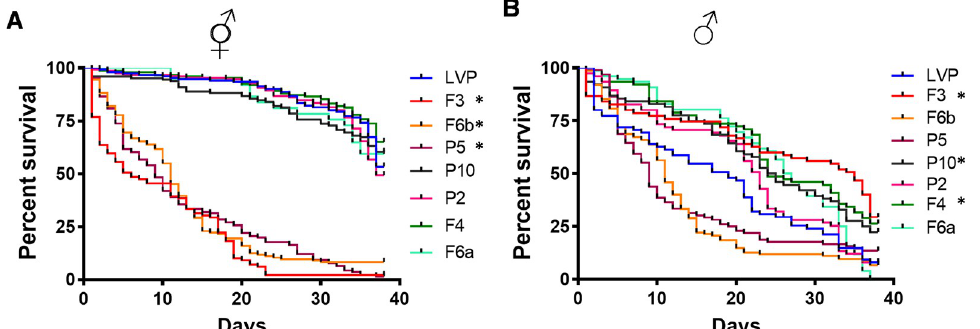
Fig 5. Transgenic females displaying higher masculinization have higher mortality. Survival curves of transgenic ( A ) transgenic females (at least 100 individuals per transgenic line) and ( B ) males (at least 75 individuals per transgenic line) and Liverpool strain (150 females and 75 males) in a total of 38 days of observation. Log-rank test was used to determine P values and statistical significance was determined after the Bonferroni method to correct for multiple testing. � : P < .07.